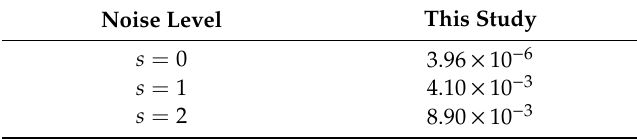
Figure 18. Absolute error of example 4. ( a ) Weighted RKCM, ( b ) Proposed approach. Table 2. The MAE by assigning di ff erent levels of noise for example